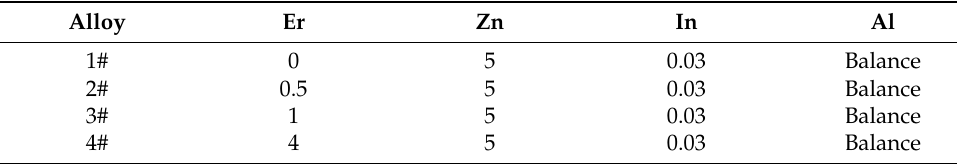
Table 1. Chemical composition tested alloys